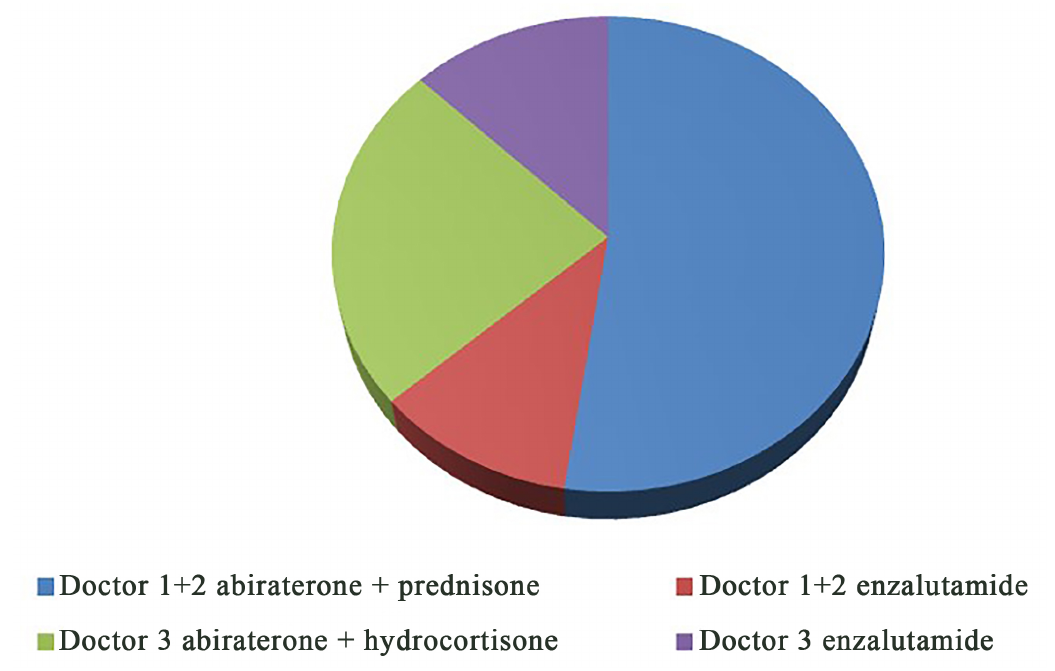
Fig. 1. Plan of the analyses. The sectors are proportional with the patient numbers. (1) Doctor 1 + 2 abiraterone + prednisone vs. Doctor 3 abiraterone + hydrocortisone, (2) Doctor 1 + 2 vs. Doctor 3, (3) Deep PSA drop vs. moderate PSA drop (not indicated on the figure). “Control”: Doctor 1 + 2 and 3 abiraterone vs. Doctor 1 + 2 and 3 enzalutamide.